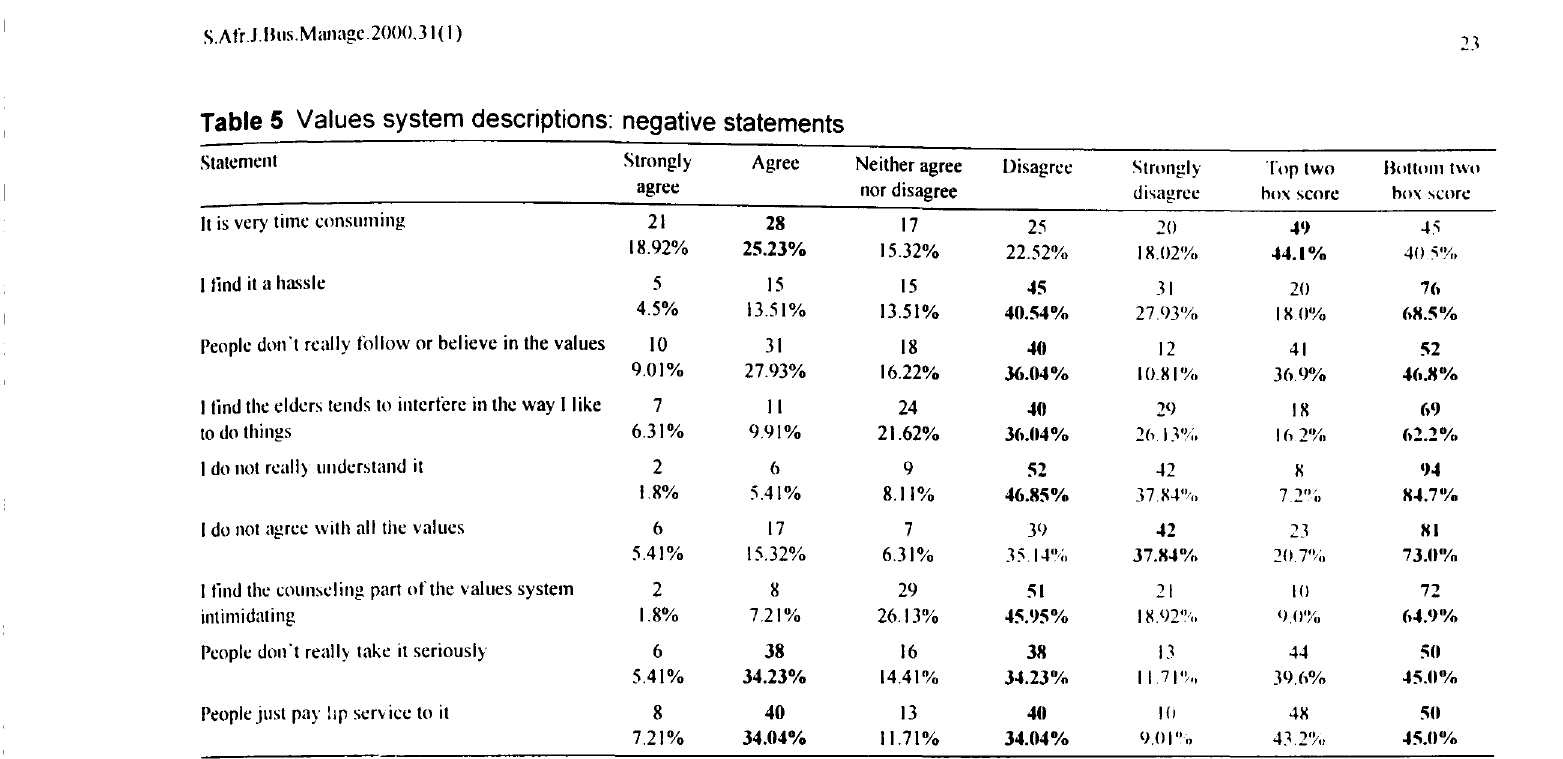
Table 5 Values system descriptions: negative